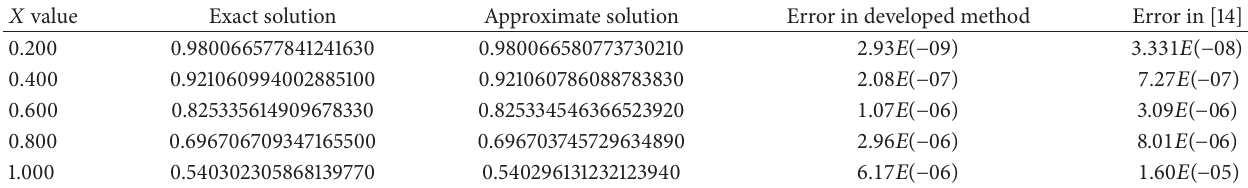
Table 4: Exact and approximate solutions for solving 𝑦 1 using the developed method.